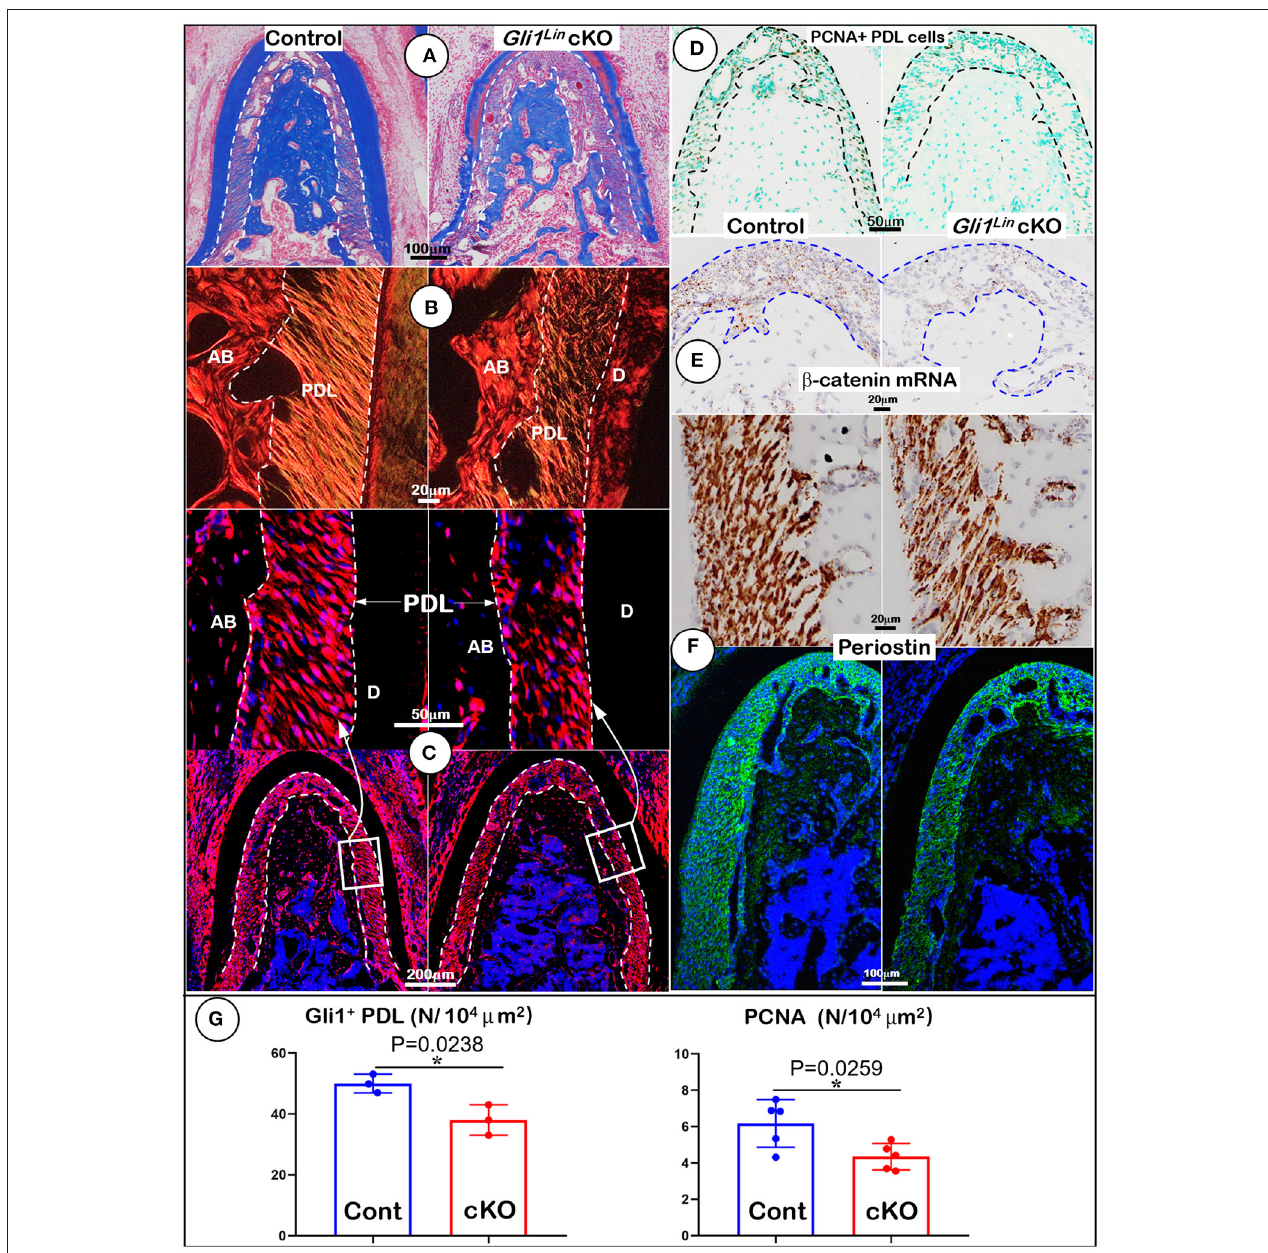
FIGURE 2 | Morphological analyses of mandibles from Gli1 Lin Tgf β r2 conditional knockout (cKO) mice at cellular levels. (A) Masson’s Trichrome staining showed drastic reduction of alveolar bone mass in cKO mice ( right ); (B) Polarized light images displayed a decrease in periodontal ligament (PDL) with a disorganized collagen fiber distribution in cKO mice ( right ); (C) Gli1 Lin tracing images revealed pathological changes in the cKO PDL: irregular cell shape and a significant reduction in tdTomato + PDL cell number compared to the spindle-shape PDL cells in the control ( upper right ); (D) The immunostaining images of PCNA showed a significant decline in proliferating cells in the cKO PDL; (E) The RNAscope images showed a drastic reduction in β -catenin mRNA level in the cKO PDL ( right ); and (F) a decrease of Periostin expression at both mRNA level ( upper right ) and protein level ( lower right ). (G) Quantitative analyses of the number of tdTomato + PDL cells ( left ) and PCNA expressing cells in PDL ( right ). n = 3–5, * P < 0.05 . AB, alveolar bone; PDL, periodontal ligament; D,